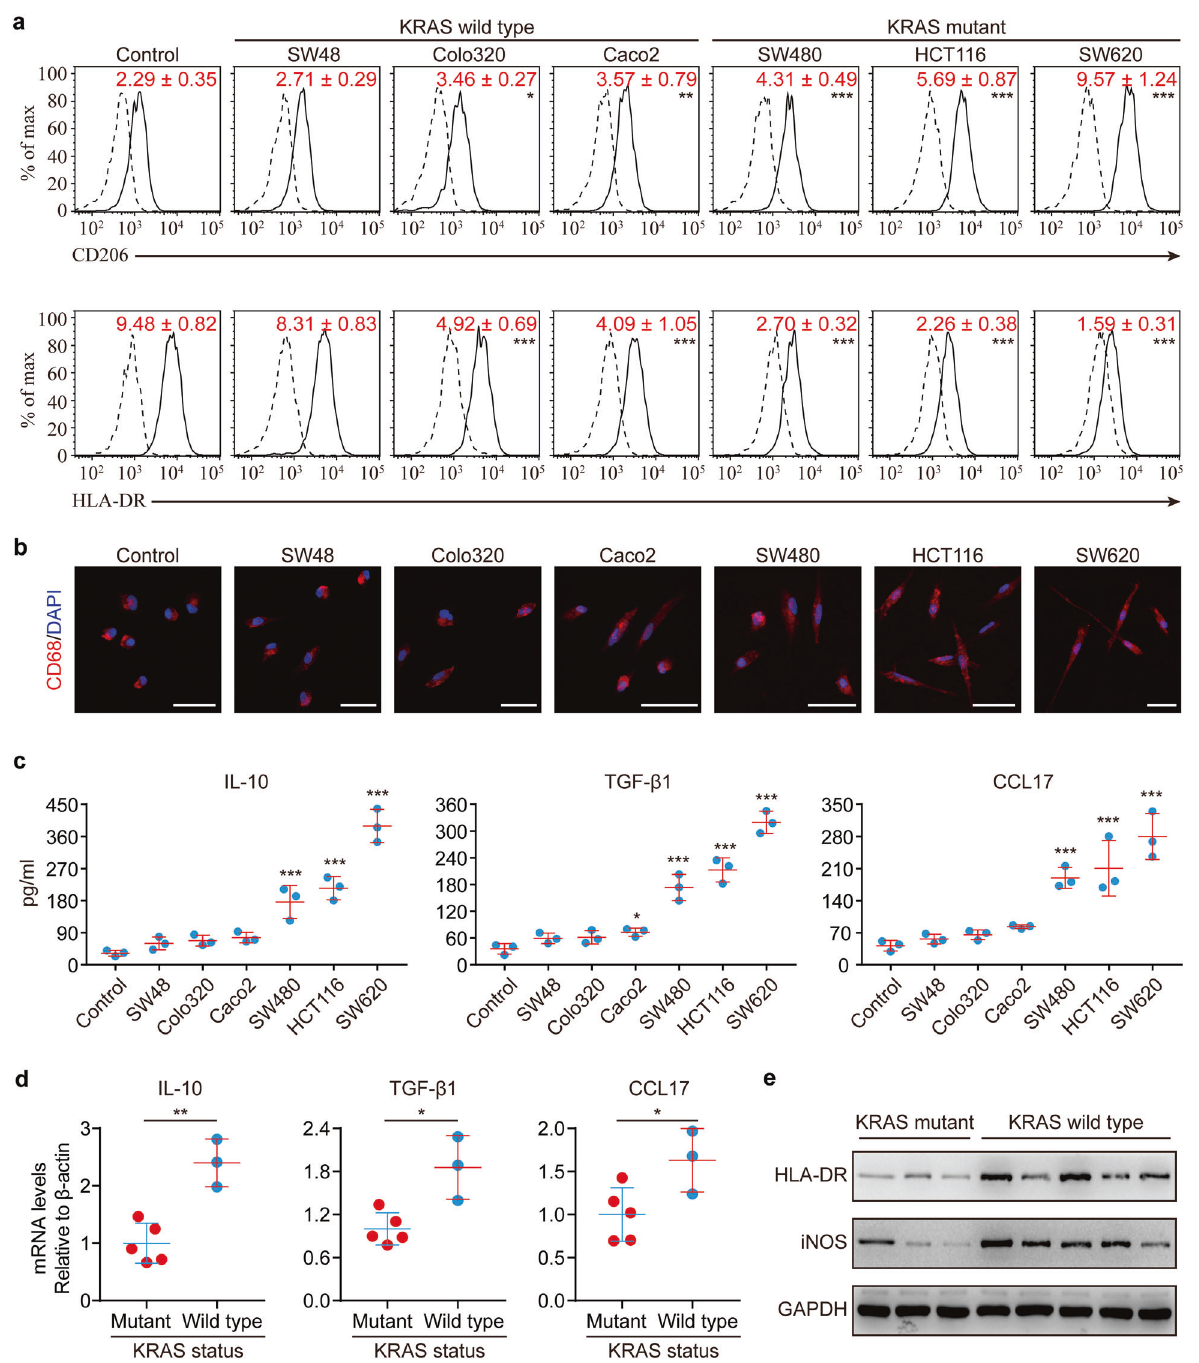
Fig. 2 KRAS mutant tumor cells have a selective advantage to reprogram macrophages to a TAM-like phenotype. a – c Macrophages were obtained by culture of monocytes in DMEM medium supplemented with 10% heat-inactivated human AB serum in the presence or absence of 30% CM from the indicated cell lines for 6 days. a Representative fl ow cytometry staining for CD206/HLA-DR in macrophages. The solid lines represent cells stained with monoclonal antibodies, and dotted lines represent those stained with isotype controls. Numerical values denote the relative mean fl uorescence intensity (RelMFI) normalized to isotype controls (mean ± SD) ( n = 3). b Immuno fl uorescence images of CD68/DAPI in macrophages. Scale bars: 30 μ m. c Cytokine levels in the media obtained from macrophage cultures ( n = 3). d , e Primary TAMs were isolated from fresh CRC tumor samples. d The levels of indicated cytokines by real-time PCR assays and e the M1 makers by immunoblots in TAMs were compared between KRAS mutant CRC tissues ( n = 3) and KRAS wild-type tissues ( n = 5). p -values are for comparison with “ Control ” ( a , c ). * p ≤ 0.05, ** p ≤ 0.01, and *** p ≤ 0.001, by one-way ANOVA ( a , c ) or by two-tailed Student ’ s t -test ( d wild-type counterparts (Fig. 2d). In contrast, KRAS mutation was a stretched and elongated morphology, and increased production inversely correlated with an M1 phenotype (Fig. 2e). of tumor-supportive cytokines (Fig. 2a, c). Moreover, TAMs isolated To verify whether the selective advantage of tumor cells to from fresh CRC tissues were shown to have higher levels of IL-10, reprogram TAMs is determined by their KRAS status, we disrupted CCL17, and TGF- β 1 in KRAS mutant patients as opposed to KRAS